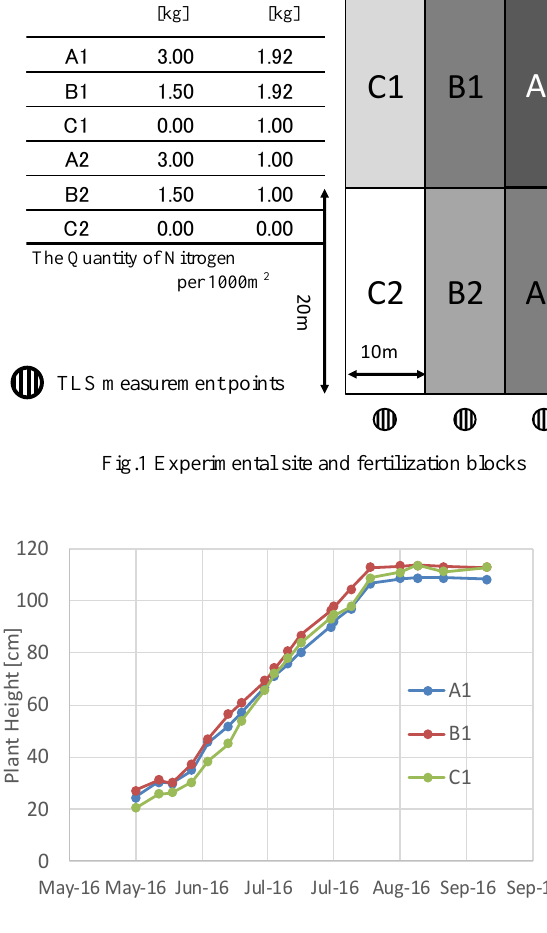
Fig.2 manually measured rice plant height